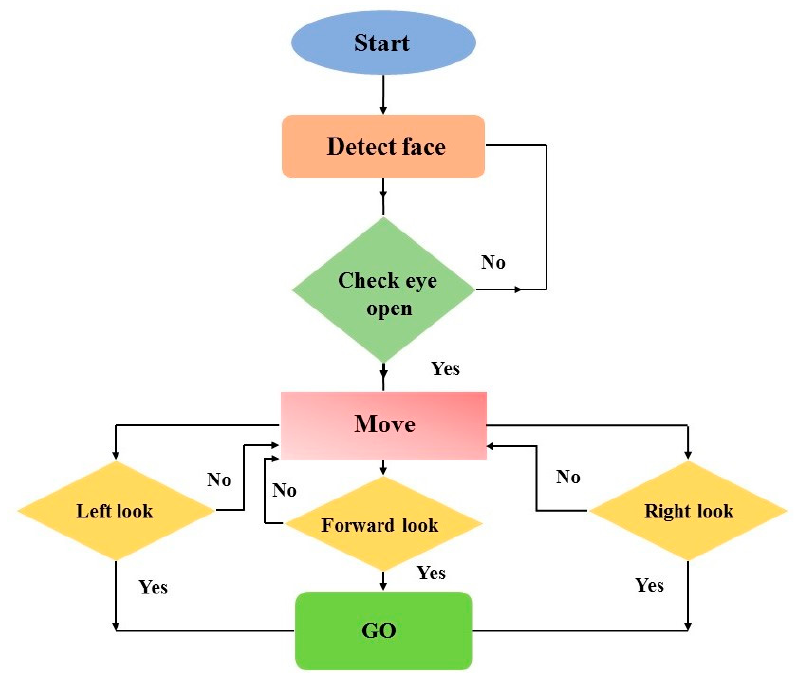
Figure 3. Functional flow chart of eye control system.